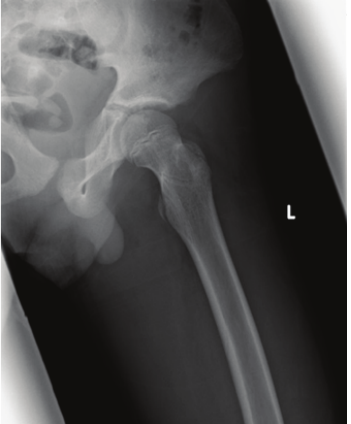
Figure 2: X-ray shows the affected side hip after reduction. The left femoral head is correctly positioned in the